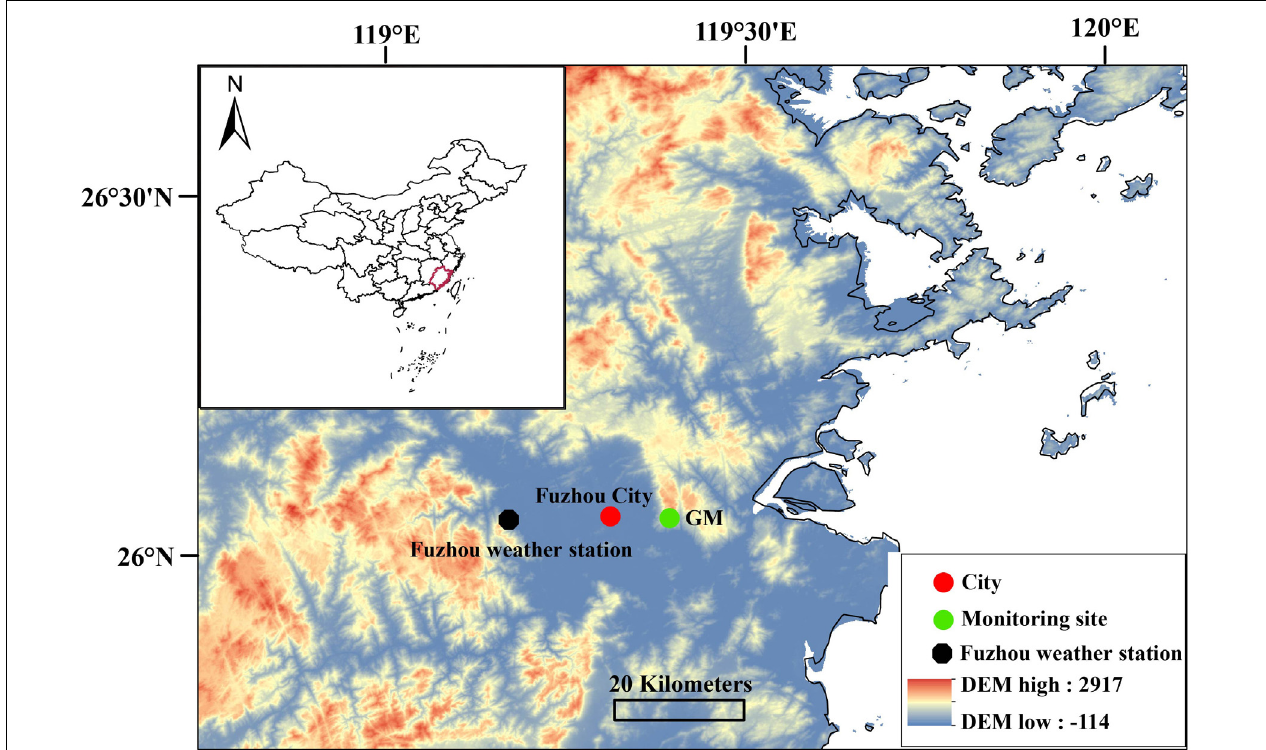
FIGURE 1 | Location of the monitoring site at the Gushan Mountain (GM) in Fujian province of China.